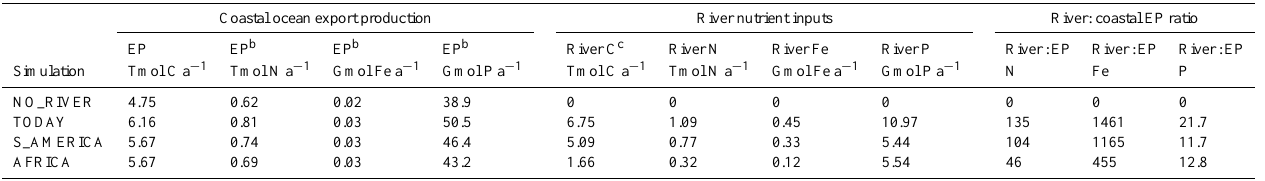
Table 5. Modeled coastal ocean EP (N and Fe), riverine inputs (N and Fe) and ratios a between riverine inputs and EP in the tropical Atlantic Ocean (20 ◦ S–20 ◦ N, 70 ◦ W–20 ◦ E).